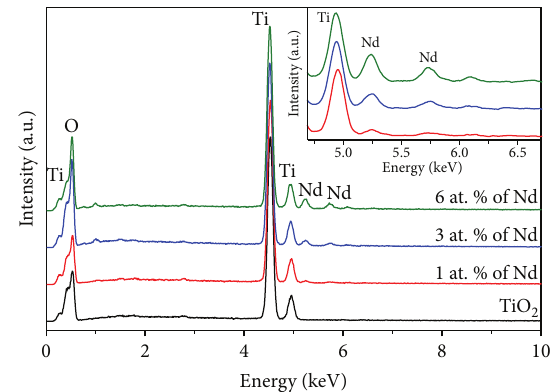
Figure 2: EDS spectra of TiO 2 nanoparticles doped with different amounts of